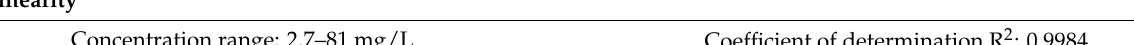
Table 2. Method validation